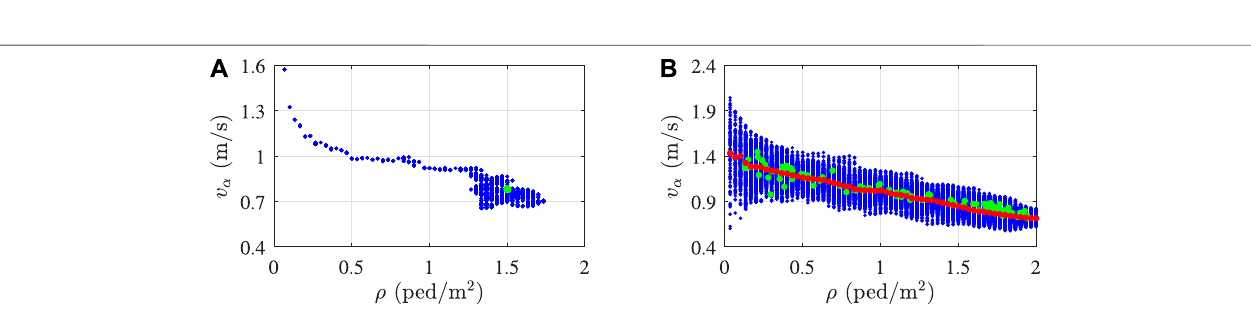
FIGURE 3 | (A) Number of pedestrians on the footbridge and (B) instantaneous crowd density (black dots) and velocity (red dots) for the case of 350 pedestrians.